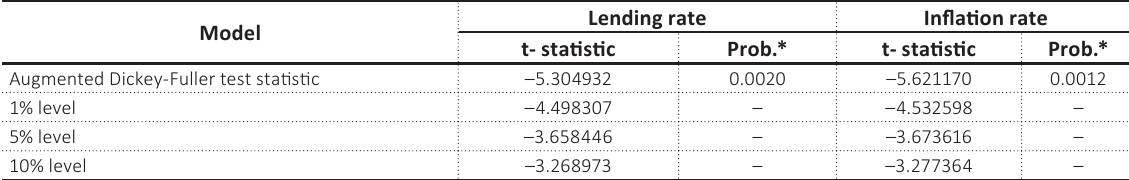
Table 5. Vietnam’s lending interest and inflation rate: first-degree difference tests I(1)